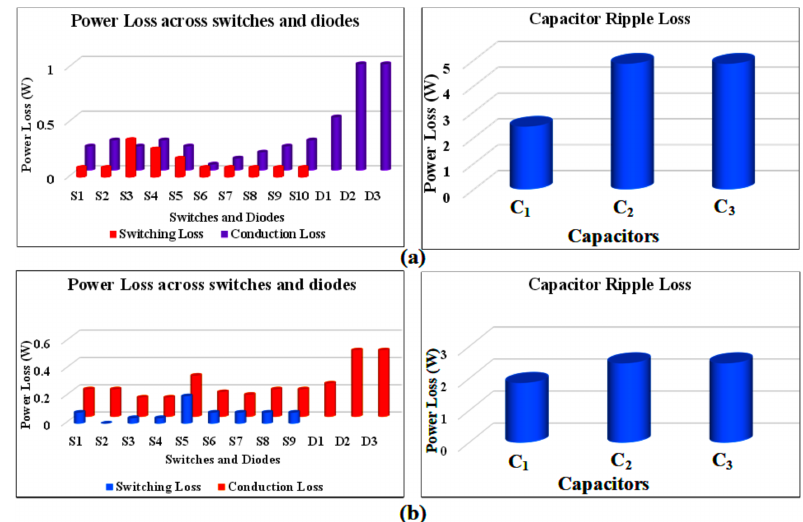
Figure 4. Power loss profile across switches, diodes, and capacitors ( a ) Topology 1 [1], ( b ) Topology 2.